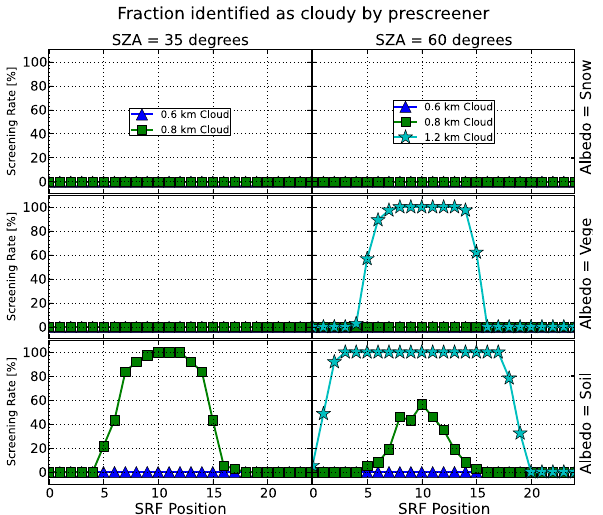
Figure 5. Fraction of simulated spectra identified as cloudy by the prescreening algorithm.